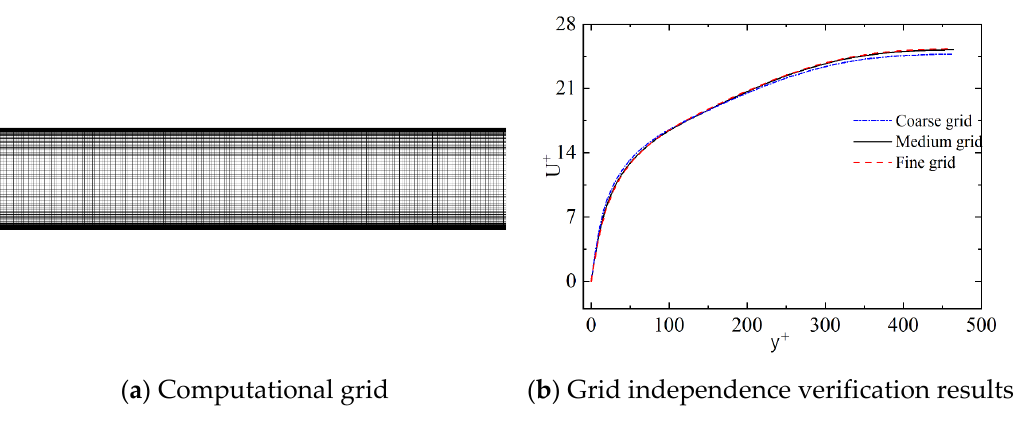
Figure 7. Grid and grid independence verification results of pipeline flow.